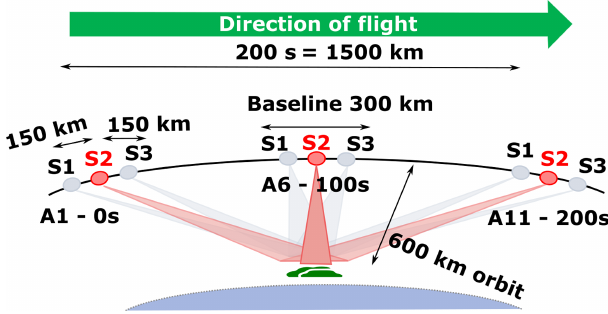
Figure 1. CLOUD (C3IEL) observational strategy: multi-view and simultaneous imaging from satellites flying at an altitude of 600km. Instantaneous (not continuous) stereoscopic pairs or triplets cap- tured every 20s over 200s – that is 11 acquisitions (A1–A11). Ac- quisitions A1, A6, and A11 occur at time t = 0, 100, and 200s,